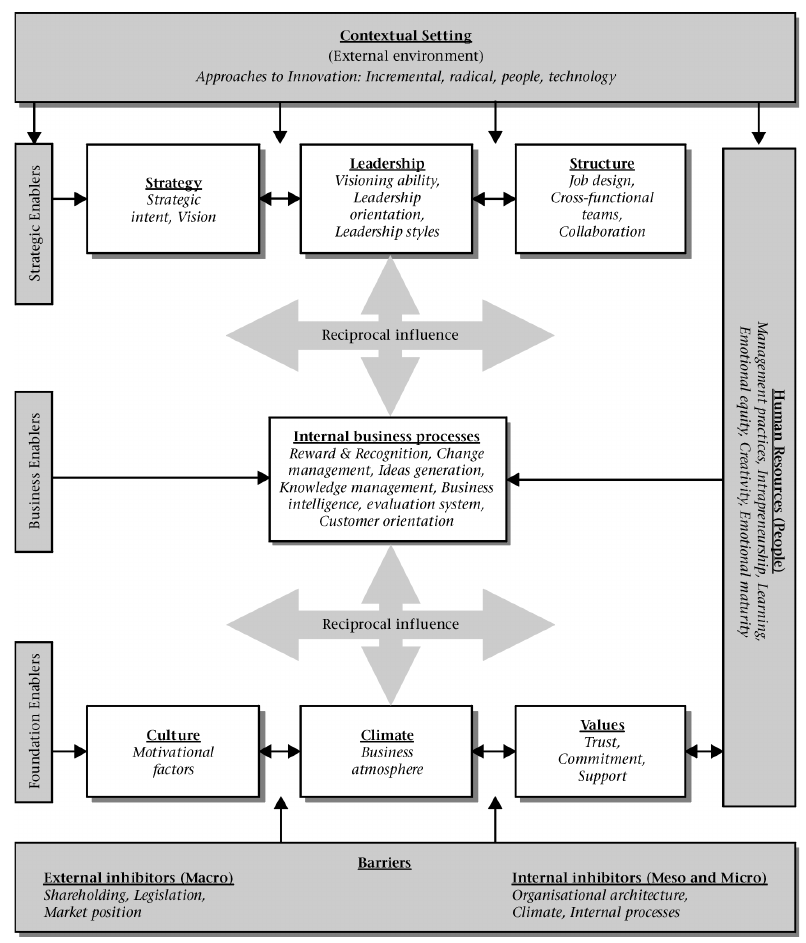
Figure 4: The SOE managers’ espoused theory on building blocks of